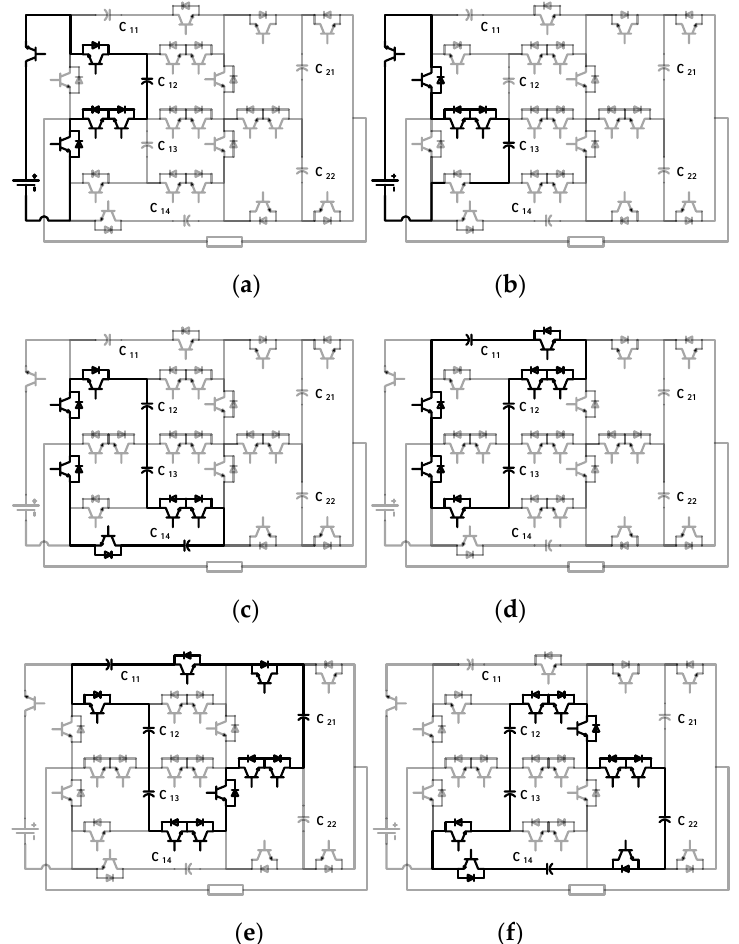
Figure 3. Capacitors charging paths for proposed SCMLI introduced in Figure 2 for ( a ) C12; ( b ) C13; ( c ) C14; ( d ) C11; ( e ) C21; ( f )